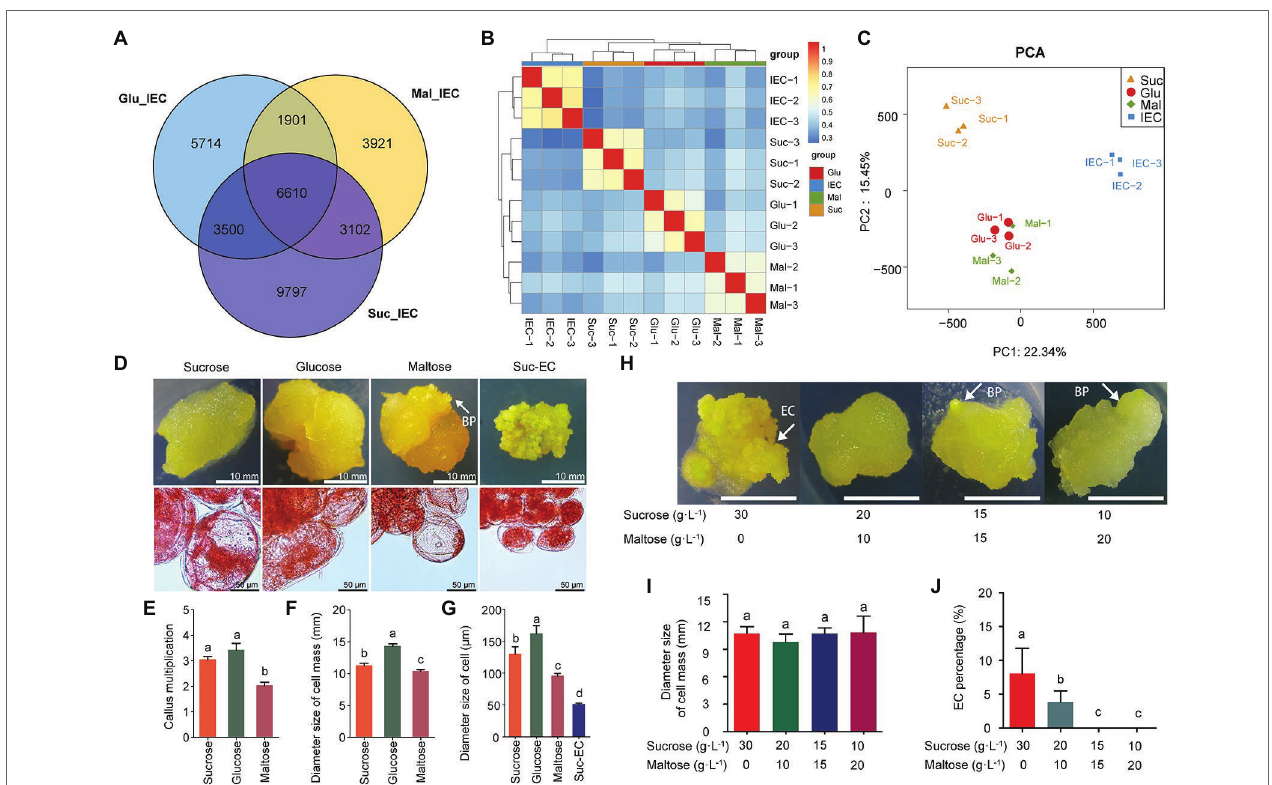
FIGURE 7 | Effects of exogenous carbon sources on cell differentiation. (A) Venn diagram of DEGs among three compared pairs (Glu/IEC, Suc/IEC, and Mal/IEC); (B) Correlation analysis among samples; the horizontal axis represents the sample clusters, and colors from blue to red indicate the correlation index from low to high. (C) PCA model of transcriptomics. (D) Morphology of the callus and cells incubated with different carbon sources; cell morphology detected by acetocarmine staining. EC was incubated on a medium including sucrose as the carbon source. (E) Statistical analysis of CA multiplication, n = 3. (F) Statistical analysis of cell mass size, n = 3. (G) Statistical analysis of single-cell size, n = 3. (H) Cell differentiation differed by carbon source combination of sucrose and maltose. (I) Statistical analysis of cell mass size, n = 3. (J) EC induction rate by the effects of carbon sources, n = 3. Data on the bars marked without the same lowercase letter indicate significant differences at p <